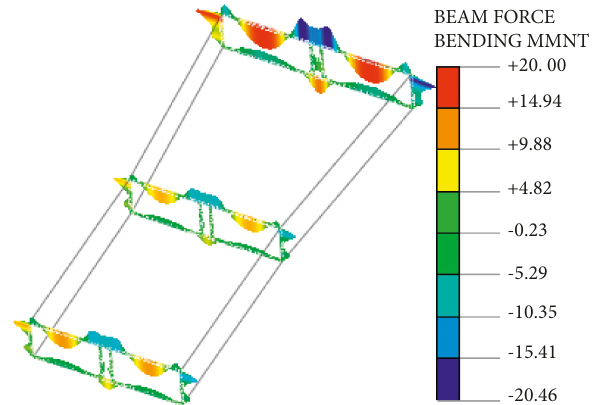
Figure 16: The bending moment of segment E1 under working condition 7 ( × 100kN · m).